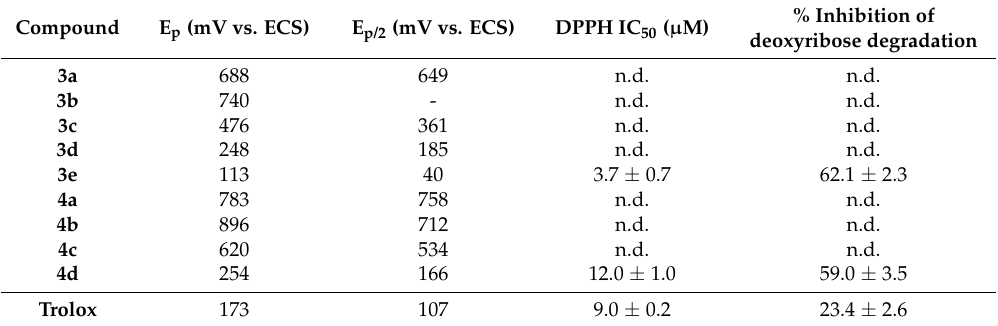
Table 2. Data from cyclic voltammetry, DPPH and deoxyribose degradation assays for the target